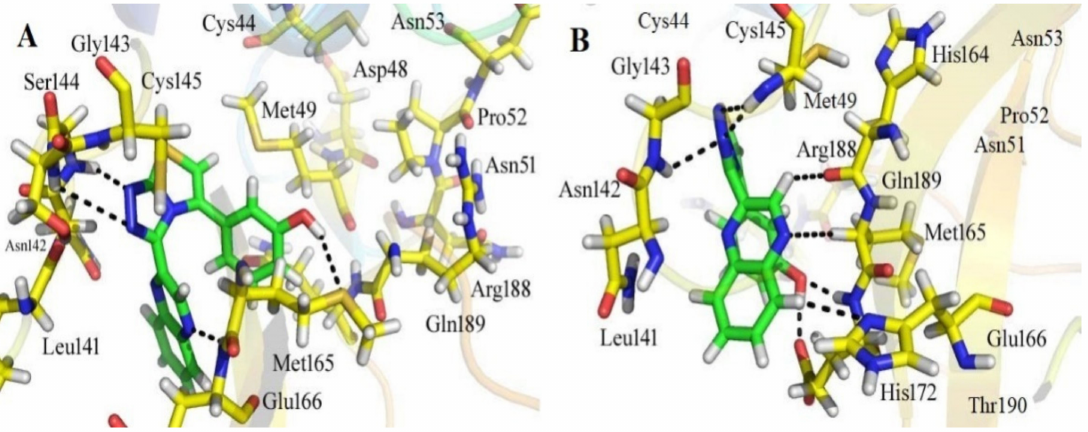
Figure 4. The binding mode of the 12-quinoxaline derivative of the in-house database within the active site of M pro protein ( A ) before and ( B ) after MDS.